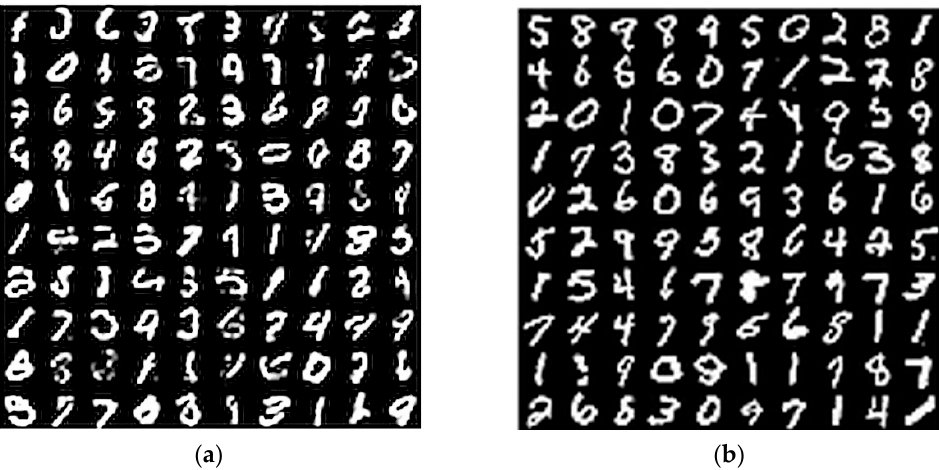
Figure 17. ( a ) Samples generated by model during semi-supervised training; and ( b ) samples gen- erated with minibatch discrimination. generated with minibatch